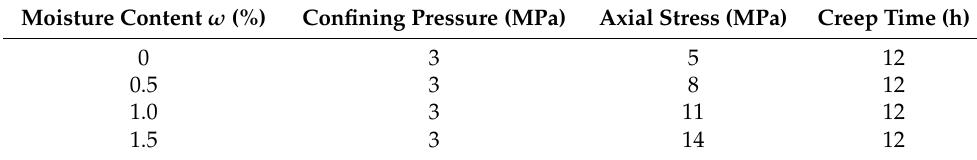
Table 2. Simulation scheme.